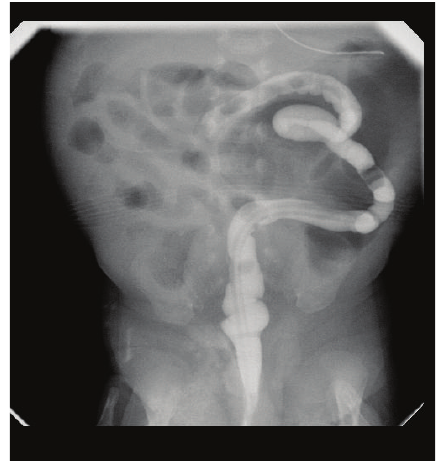
Figure2:Bariumenemashowingmicrocolonandnoprogressionof contrast proximal to the midtransverse colon suggestive of colonic obstruction.